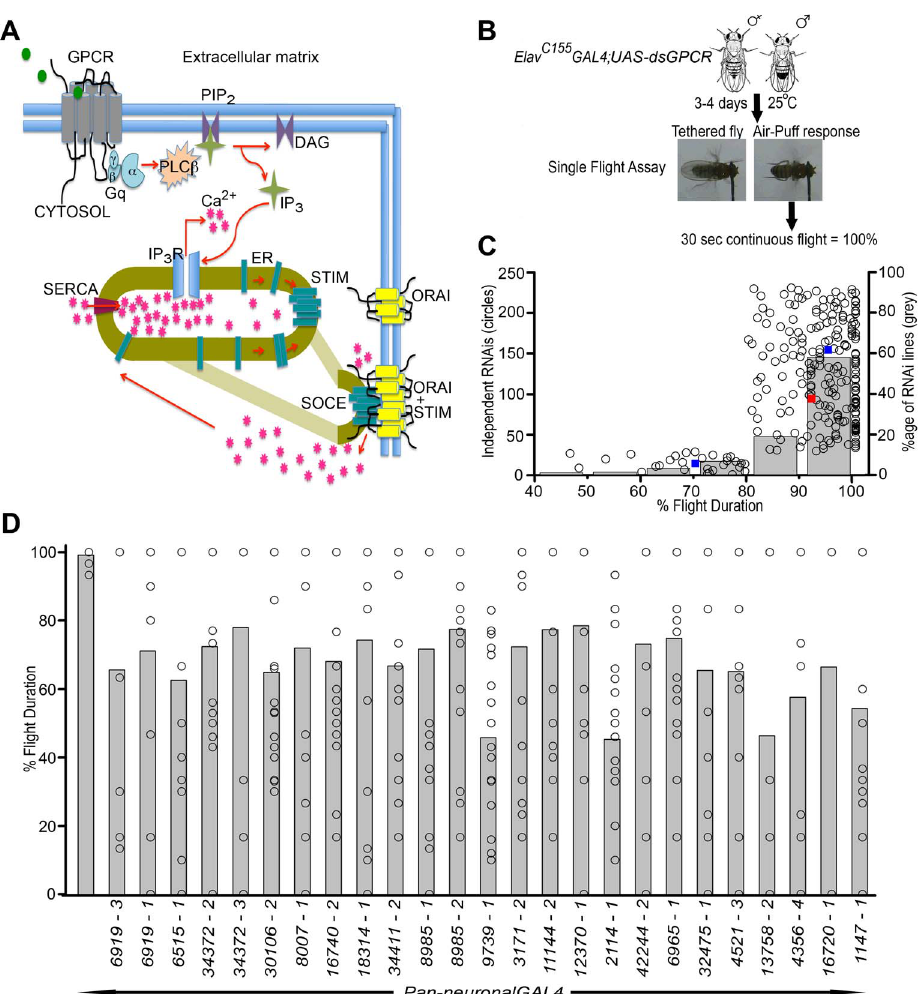
Figure 1. A genetic RNAi screen for G-protein coupled receptors that regulate flight in Drosophila . A ) A schematic of how GPCR activation can stimulate the IP 3 R mediated Ca 2 + signaling pathway and Store-operated Ca 2 + entry (SOCE) through STIM and Orai. Gq is a heterotrimeric G-protein that acts downstream of IP 3 R linked GPCRs and activates PLC b upon ligand-binding to the GPCR. STromal Interacting Molecule (encoded by dSTIM in Drosophila ) is an ER membrane protein that can sense reduced Ca 2 + in the ER store upon IP 3 R-mediated Ca 2 + release and subsequently activates SOCE from plasma-membrane localized Orai channels. B ) A schematic representation of the screening strategy for identifying G-protein coupled receptors (GPCRs) required in Drosophila flight. Flies (n $ 10) with pan-neuronal ( Elav C155 GAL4 ) knockdown of individual GPCR were collected and tested for flight. Non-stop flight for 30 sec after a gentle air-puff was taken as 100% flight. C ) Mean percentage time of flight for each genotype tested (open circles) is shown in increasing order. The average of all mean percentage flight times is shown as a red box. Average of mean percentage flight time for genotypes above and below 80% flight time are shown as blue boxes, and were found to be significantly different from each other (P , 0.005). Therefore, flight time of 80% was considered as the significant cut-off for identifying putative GPCRs affecting flight. Grey bars show the number of RNAi strains lying within the indicated intervals of 10% of flight time. D ) Individual GPCR RNAi strains identified with a mean percentage flight time of less than 80%. Each strain has been referred to by its CG number and the individual RNAi number (described in Table S1). Open circles within the bars show percentage flight times for each fly. Where flight times overlap a single open circle is shown. All RNAi heterozygotes (Table S1) and the pan-neuronal GAL4 used in these experiments (column on extreme left) showed normal flight durations.